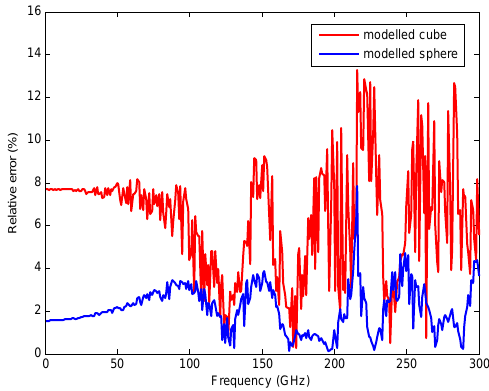
Fig. 2. Maximum relative error of Csca of randomly oriented ice cubes and ice spheres as a function of the frequency compared to the exact Mie solution of an equal volume sphere.